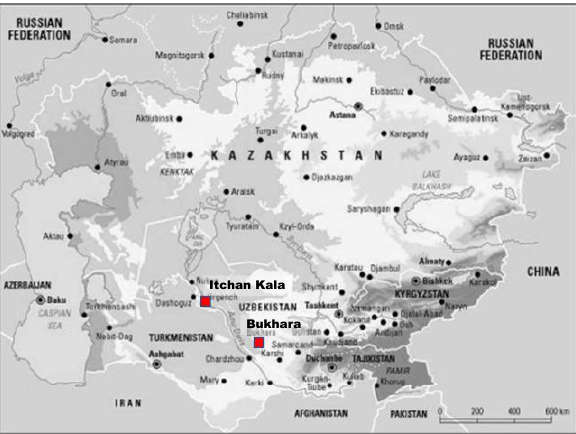
Figure 2 Map of Central Asia showing the location of the case studies, Itchan Kala and Bukhara, in red